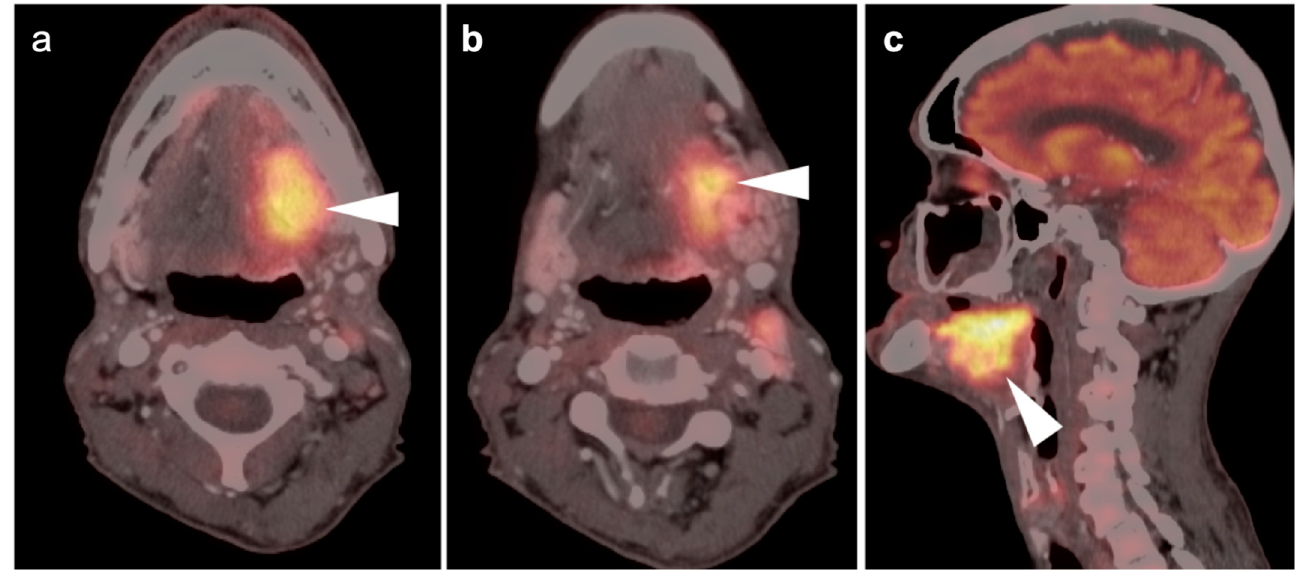
Figure 11. Squamous cell carcinoma of the oral tongue on FDG PET-CT. ( a ) Hypermetabolic tumor involves the left oral tongue (white arrowhead). ( a , b ) There is spread to the left floor of mouth musculature shown on both axial ( b ) and sagittal ( c ) imaging (white arrowheads). ( b ) There is also a left level 2A hypermetabolic cervical lymph node consistent with nodal spread of disease.